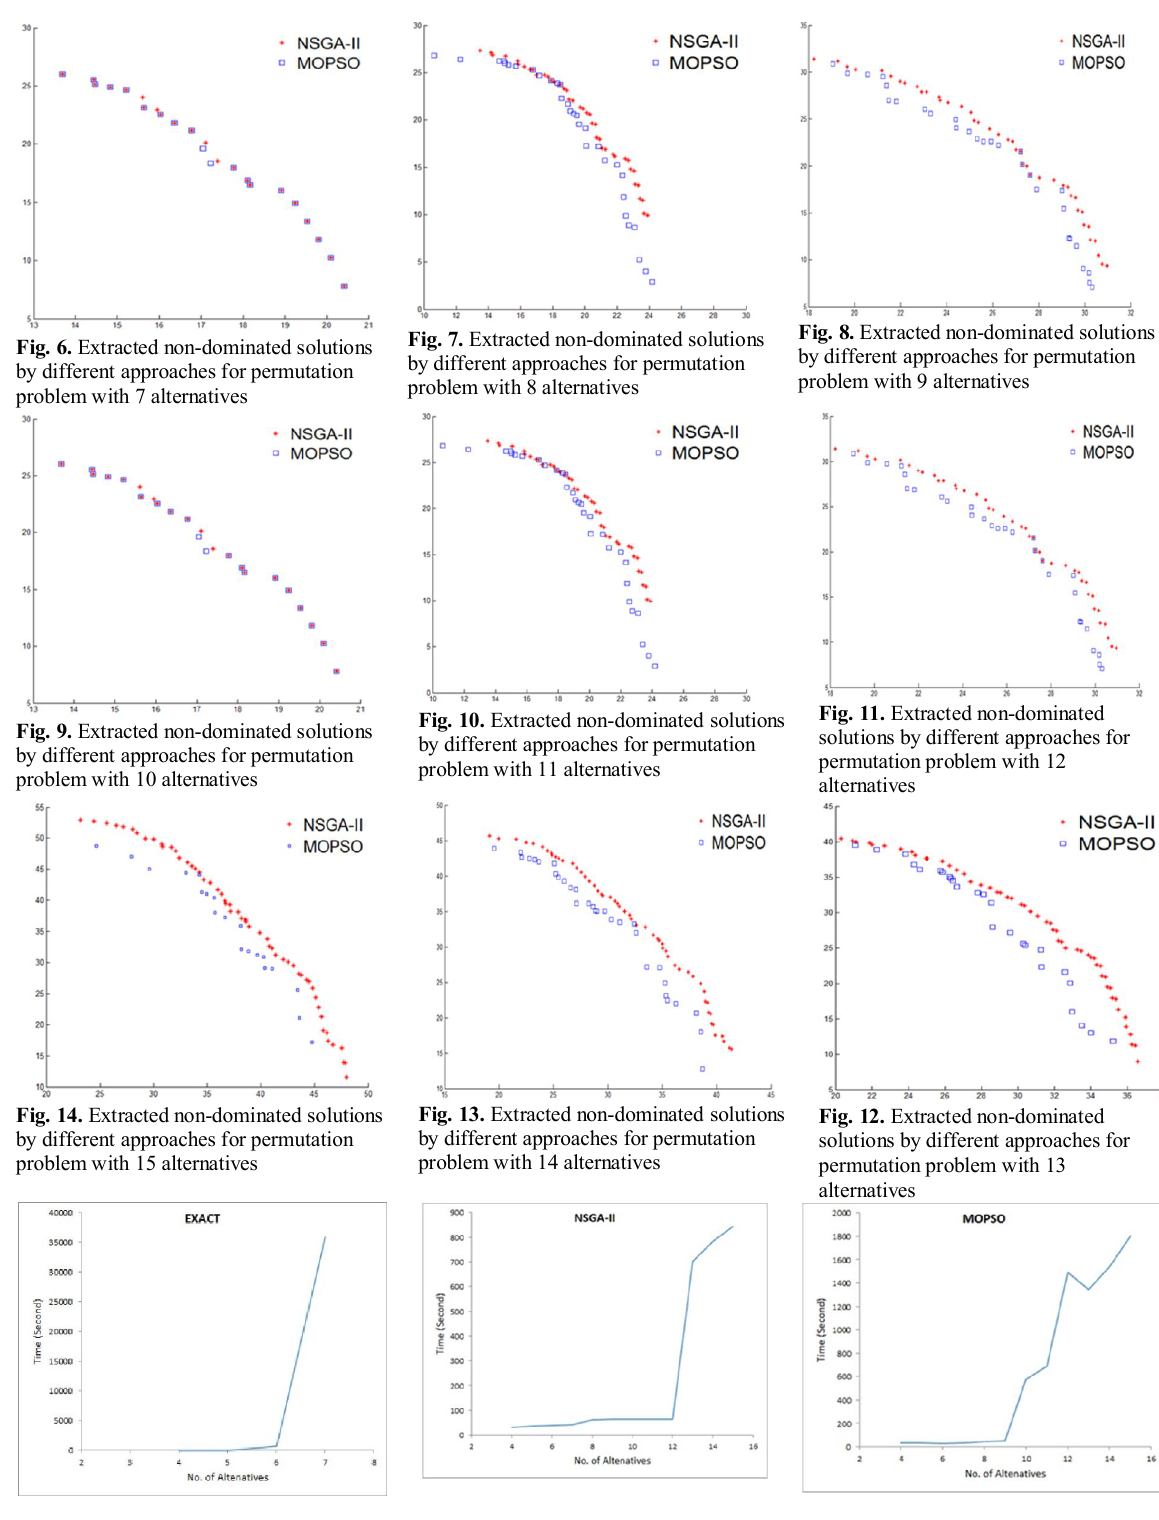
Fig. 15. Computational time slope by increasing of problem size in Exact, NSGA_II and MOPSO solution